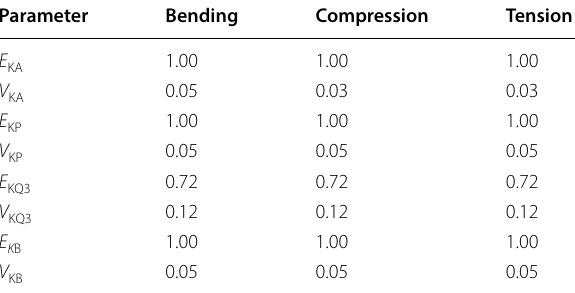
Mean value and COV of a variable K is denoted as E K and V K , respectively. E KQ3 is multiplied with a modification factor of 1.2 and 0.8 for construction load and load of long duration,